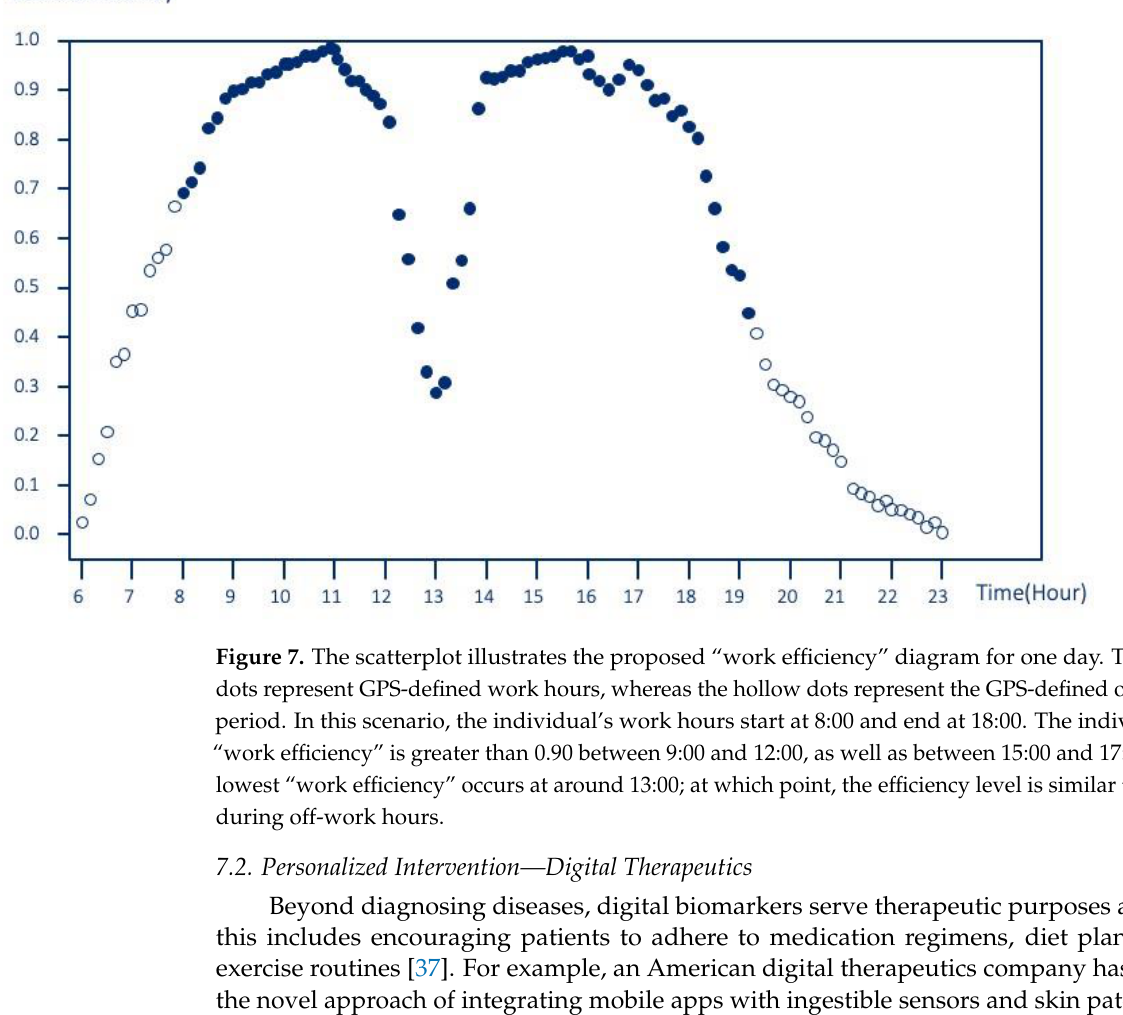
Figure 6. The deep learning model is trained by smartphone usage patterns and the corresponding GPS-defined working status. Smartphone usage patterns are formulated as a time series of screen- on/off, notifications, and types of mobile apps. The GPS-defined working/off-working statuses are labeled as 1 or 0. We will train a multilayer deep neural network and tune the weighing of the model. The trained deep learning model yields a probability between 0 and 1 from any time series of the smartphone usage patterns. This working probability can be interpreted as the work efficiency.